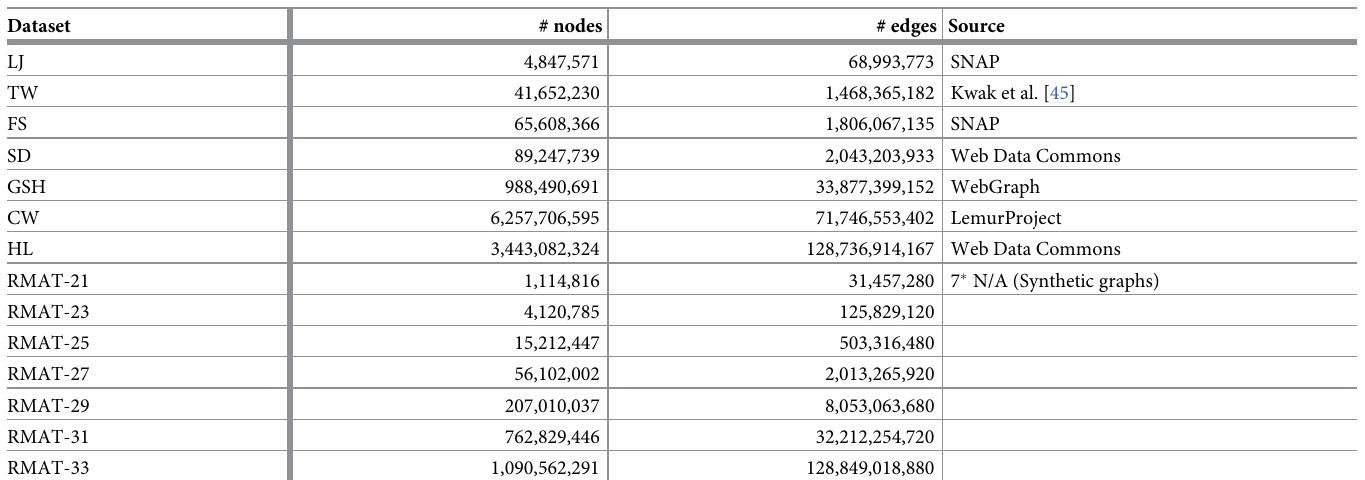
Table 2. The summary of